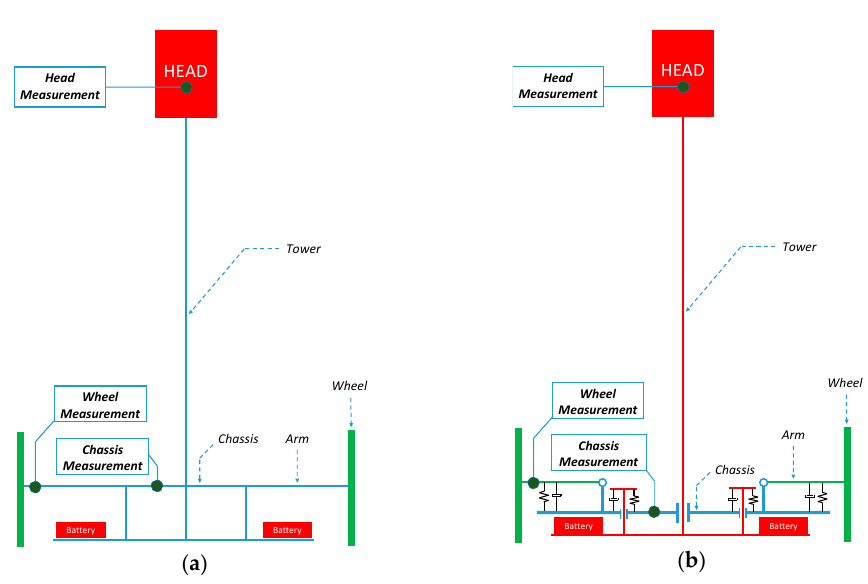
Figure 3. Structural diagram of the ( a ) APR-1 prototype and the ( b ) APR-2 prototype. The dark green dots depict the location of the measurement points: wheel, chassis, and head.